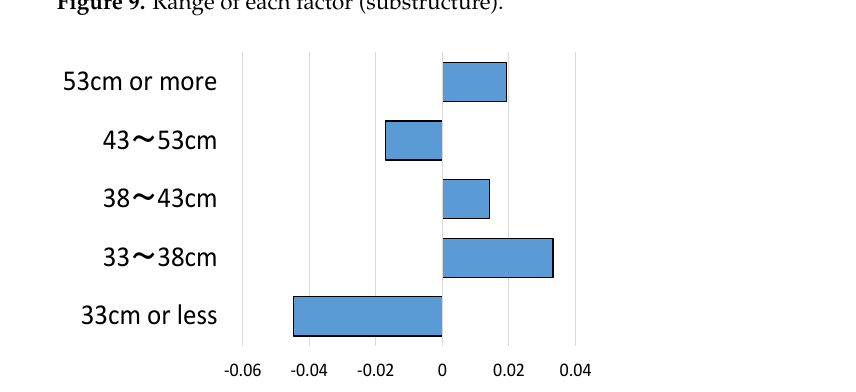
Figure 10. Annual maximum snow depth category scores (substructure).